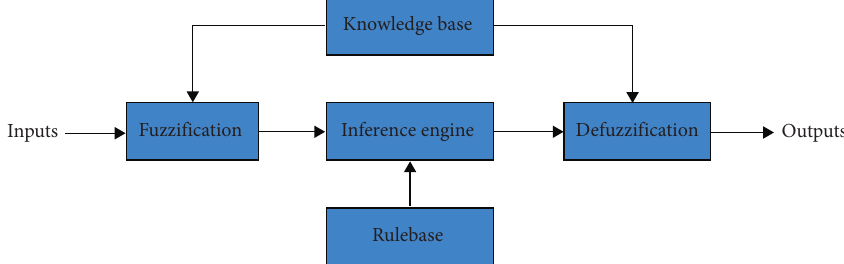
Figure 10: Structure of a fuzzy inference system. Its mathematical model can be expressed as [18–22]